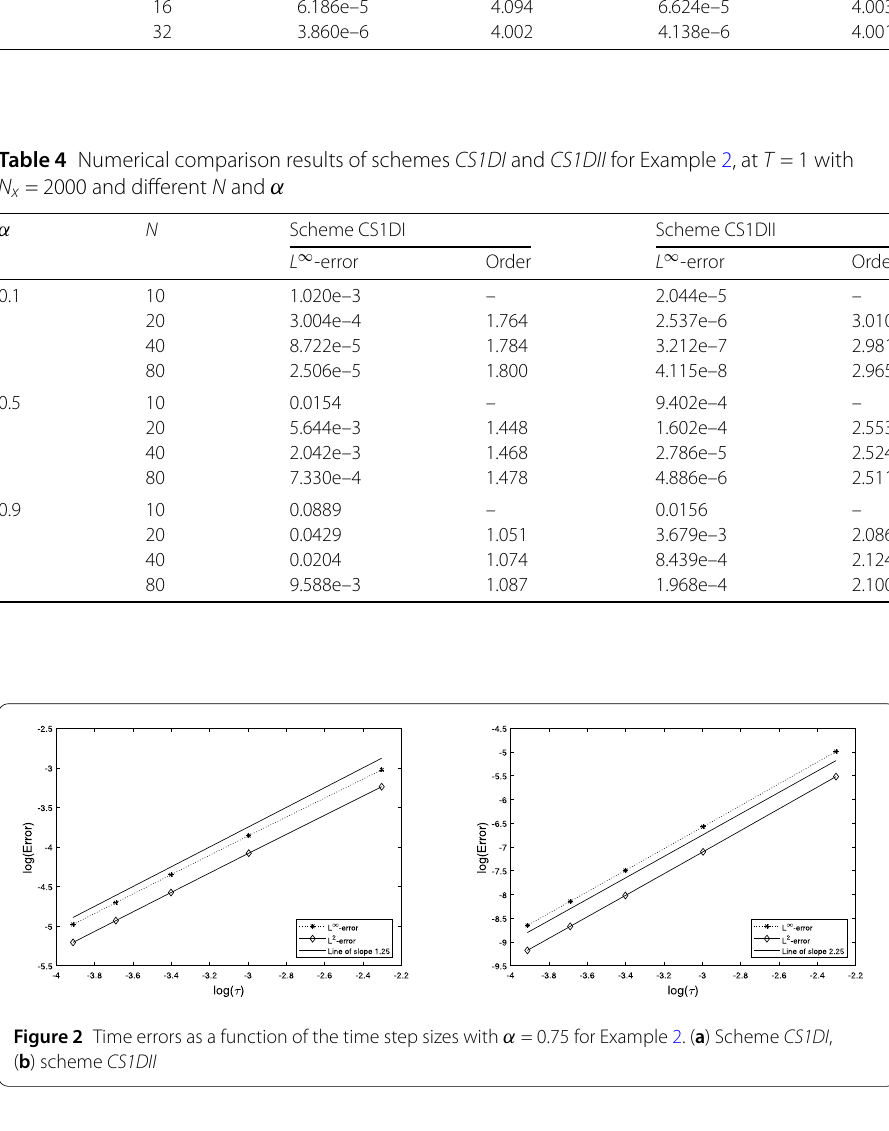
scheme CS1DI is 1.25, which accords with the theoretical estimates 2- α . However, scheme CS1DII yields a temporal approximation order 3- α , i.e., the slopes of the error curves is 2.25. Again, as expected it is clearly shown that scheme CS1DII has higher accuracy than